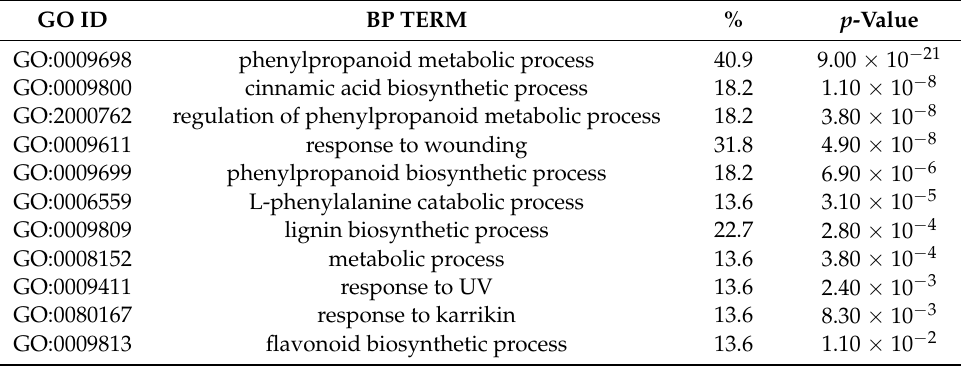
Table 2. Enriched GO term of biological process (BP) function in A. spathulifolius regarding